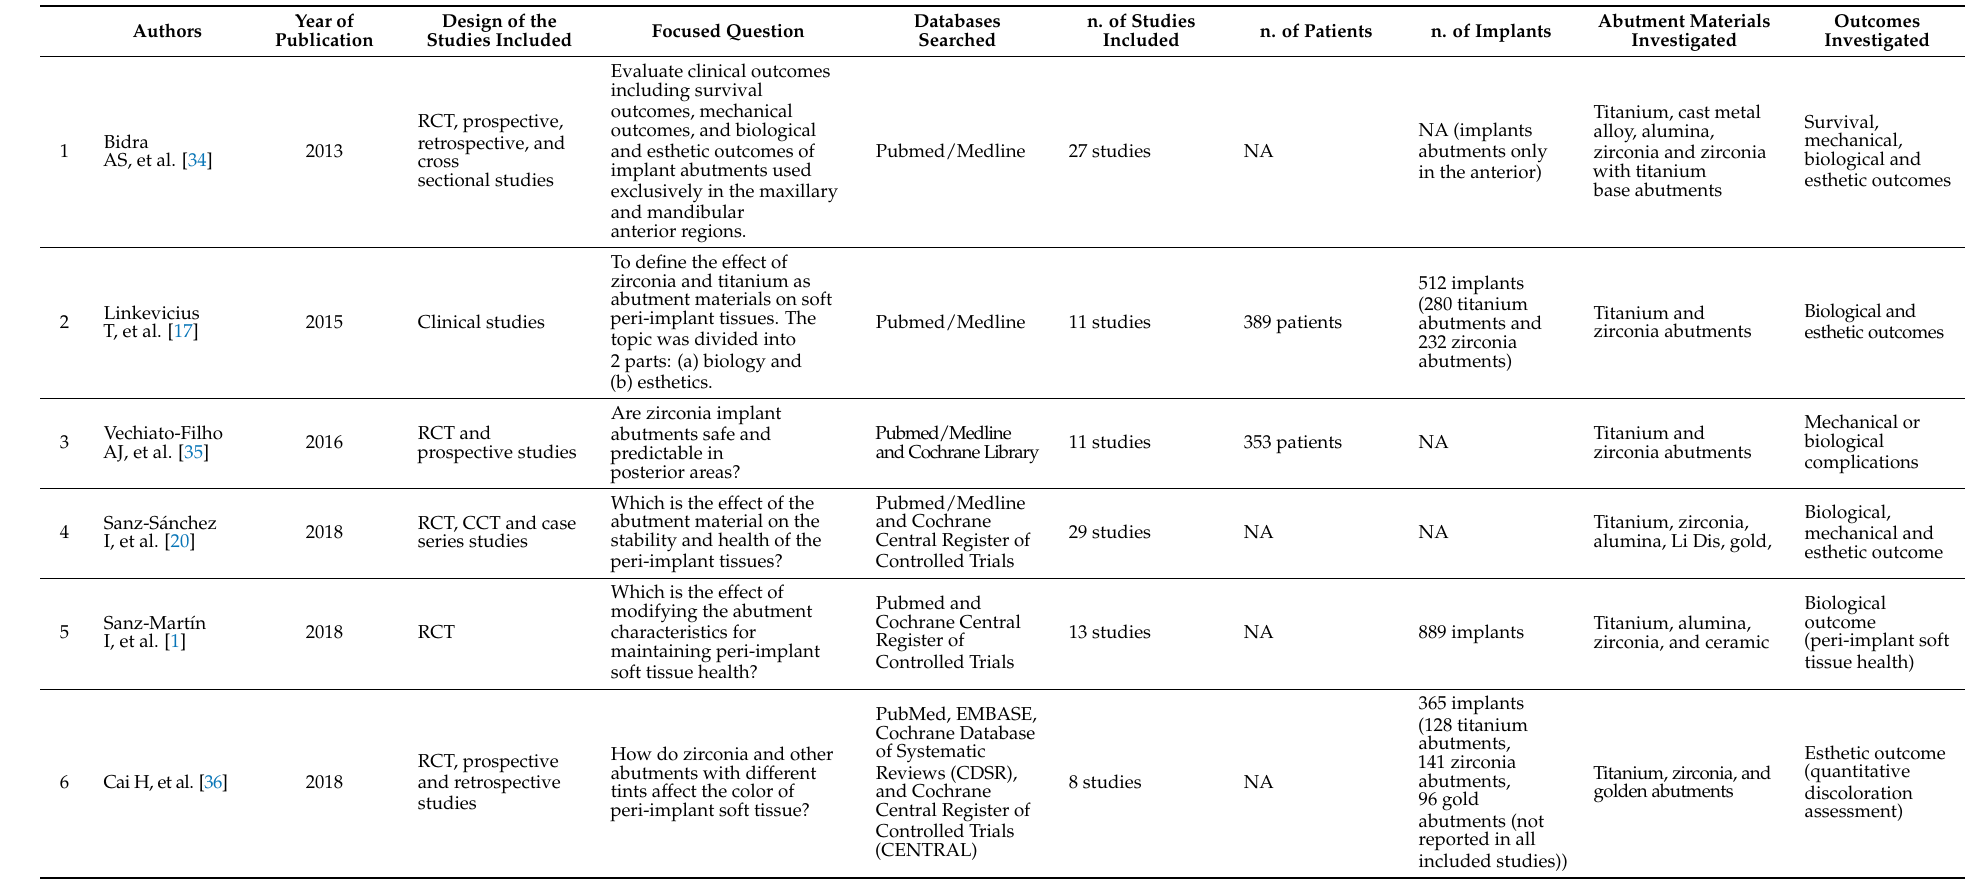
Table 2. Main characteristics of the articles included in the present